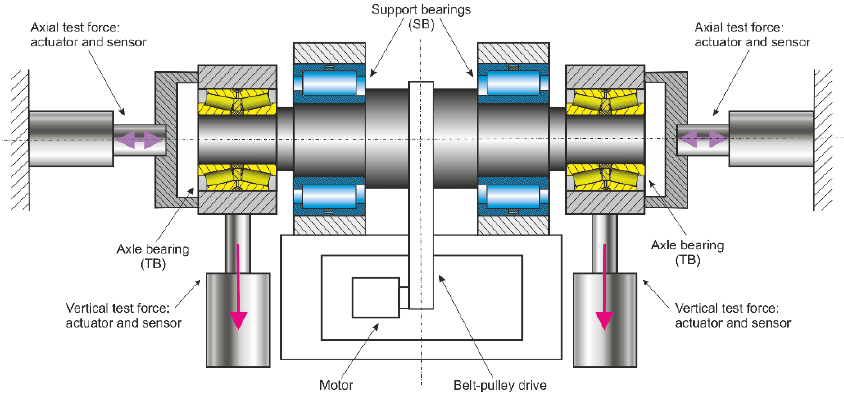
Figure 1. Outline of the main components of a test-rig compliant with EN 12082:2017 standard. A couple of axle bearings are simultaneously tested (TB, in yellow) and are installed on the extremities of a stub shaft, under vertical and axial loading.